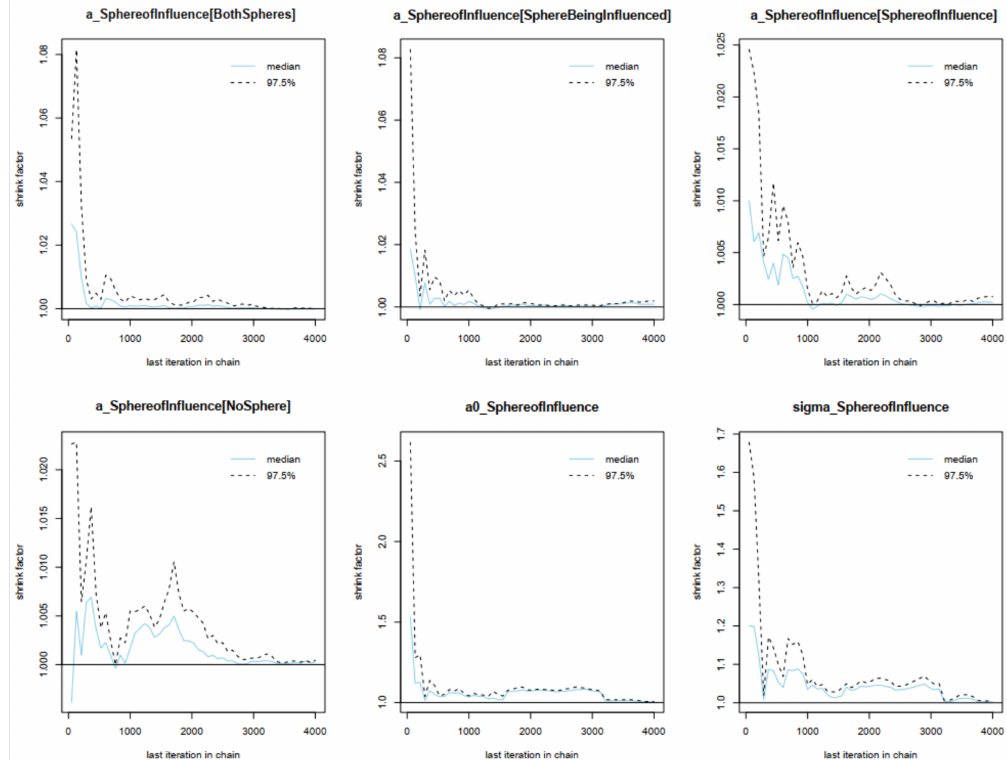
Figure A2. Model 1 (cid:48) s Gelman–Rubin–Brook plots.